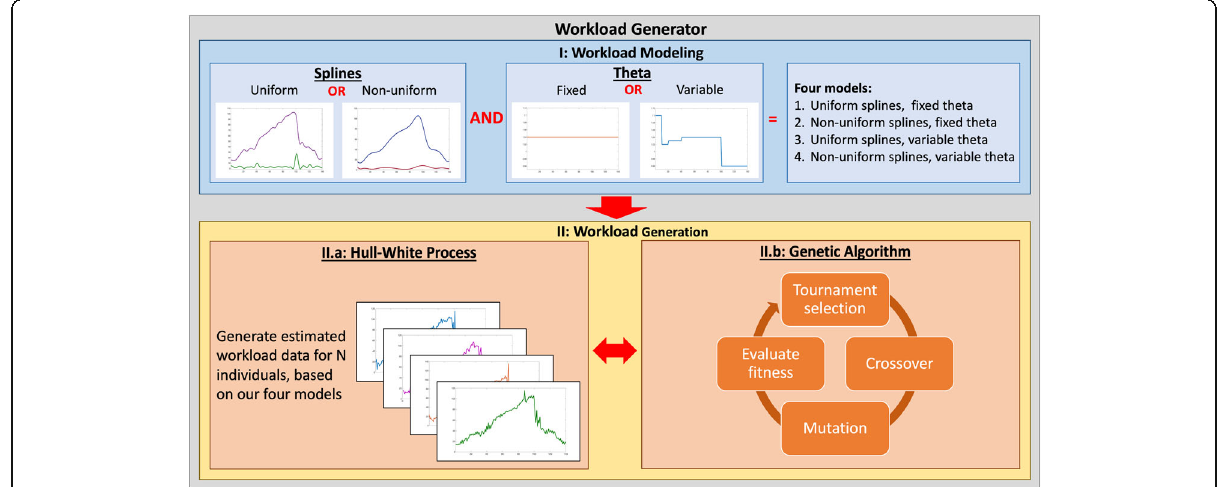
Fig. 1 Proposed Workload Generator